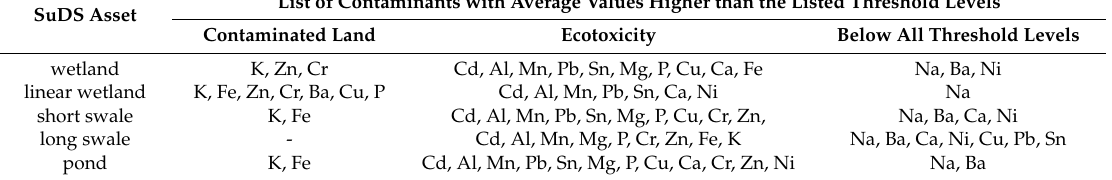
Table 6. Summary of average contaminant concentration levels relative to contamination classifications. List of Contaminants with Average Values Higher than the Listed Threshold SuDS Asset